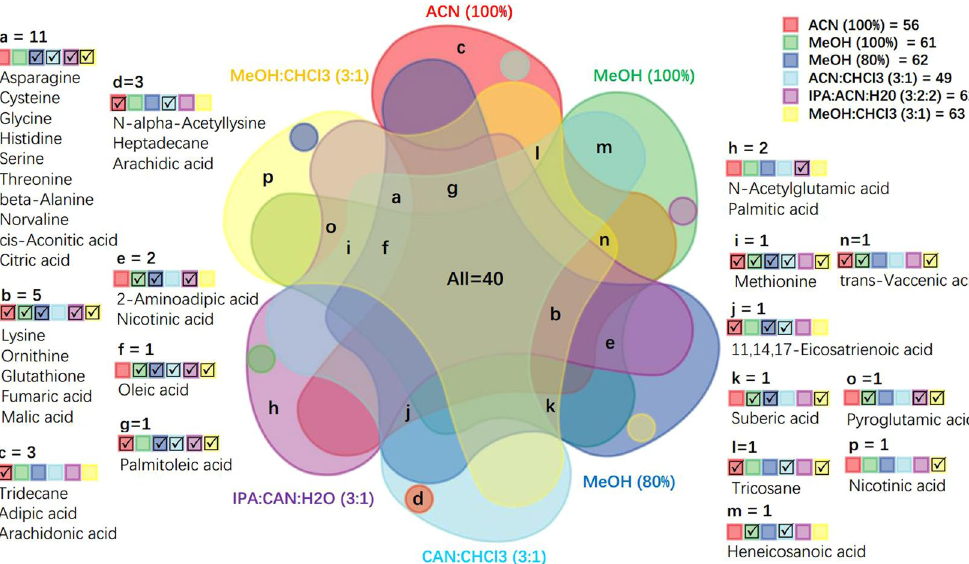
Figure 5. Six-way Venn visualization of the identified metabolite coverage compared across six different extraction methods, in adult panda feces. Red: ACN (100%); green: MeOH (100%); blue: MeOH (80%); cyan: ACN:CHCl 3 (3:1); purple: IPA:ACN:H 2 O (3:2:2); yellow: MeOH:CHCl 3 (3:1). Letter = number of identified metabolites in each color region. √ the existence of extraction methods in the overlapped region.